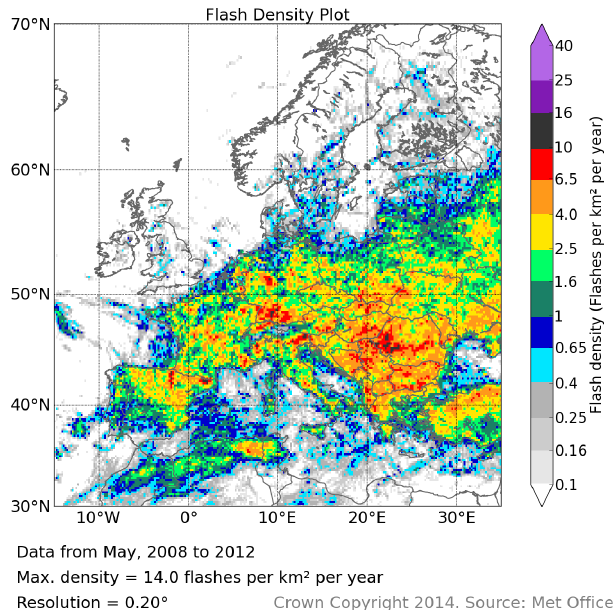
Fig. 9. Detected lightning flash density for May.